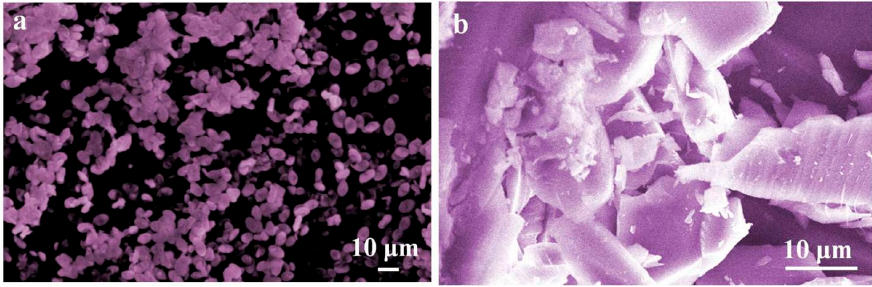
Figure 8. SEM images of ( a ) Co/BDC MOF; ( b ) Co/BDC ICP fabricated by dropping method.